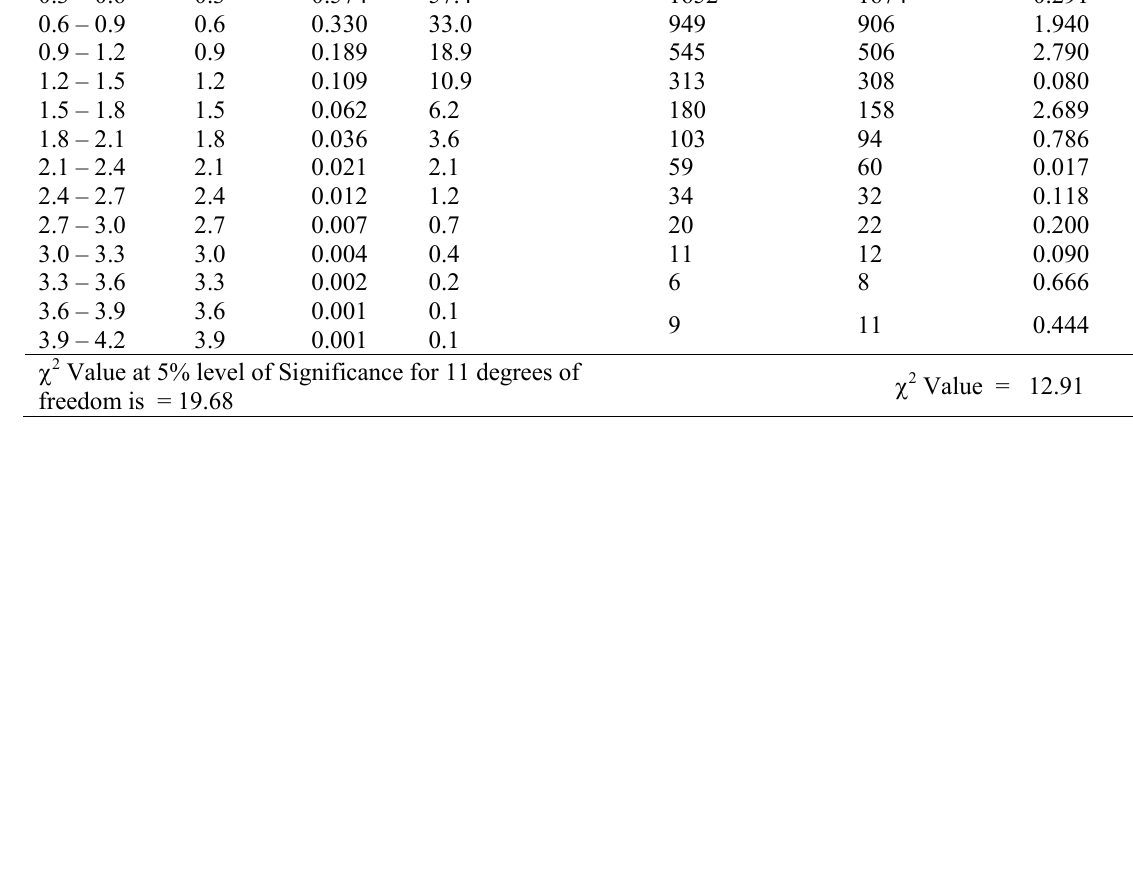
Table 2. Chi-Square goodness of fit test for headway distribution Class